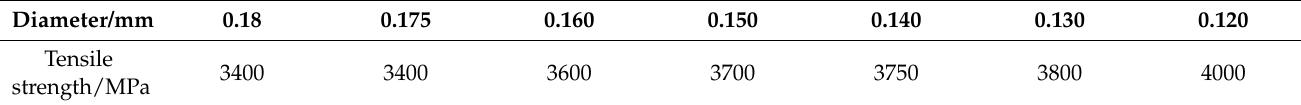
Table 2. The properties of a saw wire rod.